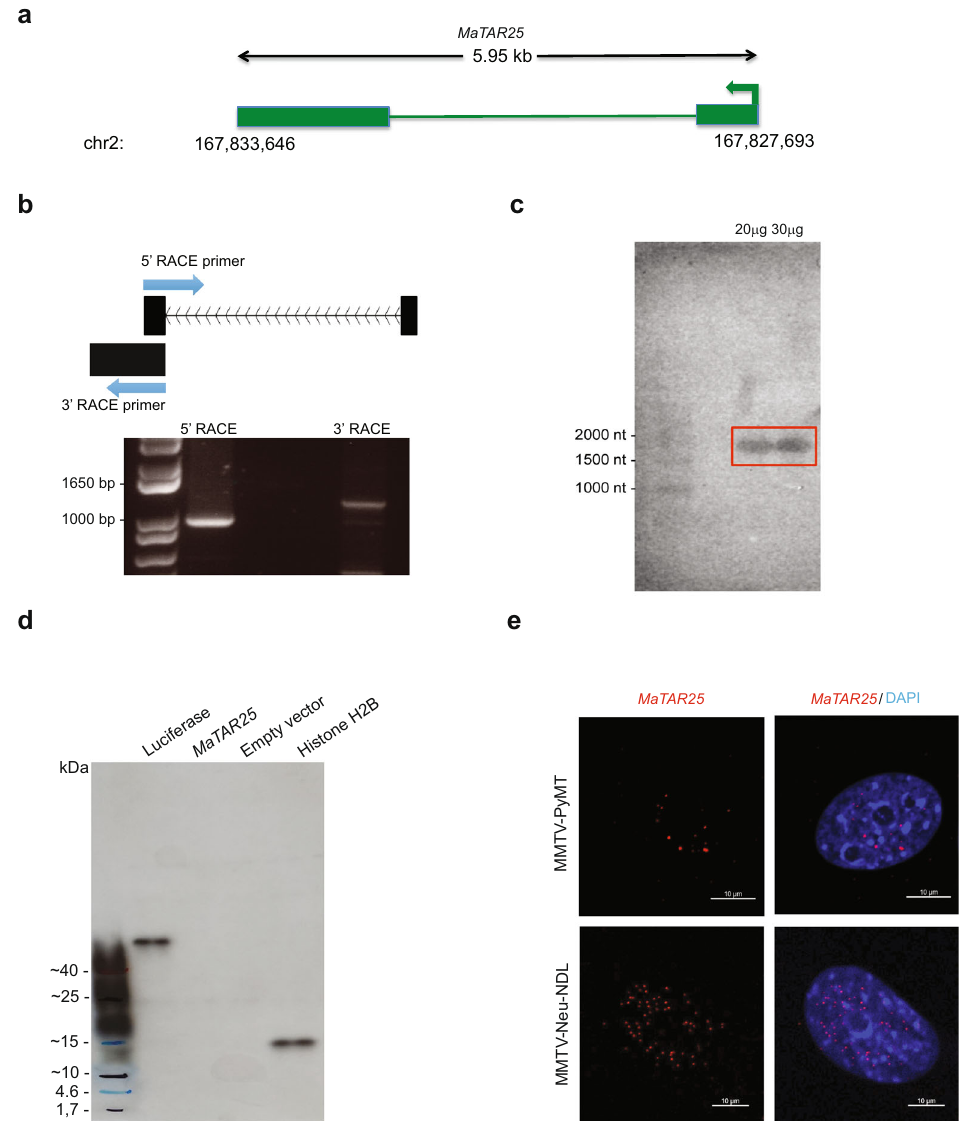
Fig. 1 Characterization of Mammary Tumor Associated RNA 25 ( MaTAR25 ). a Representation of the MaTAR25 gene locus. MaTAR25 is an intergenic lncRNA gene located on mouse chromosome 2, and the MaTAR25 RNA transcript contains 2 exons and a poly (A) tail. b 5 ′ and 3 ′ rapid ampli fi cation of cDNA ends (RACE) was performed to identify the full-length MaTAR25 transcript. Three independent experiments were performed, and a representative gel image is shown. c The full-length MaTAR25 transcript was con fi rmed by northern blot analysis to be ~2000nt. In total, 20 μ g or 30 μ g of total RNA samples extracted from MMTV-PyMT primary cells were electrophoresed on a 1% agarose gel and probed. Two independent experiments were performed, and a representative gel image is shown. d In vitro transcription and translation reactions were performed to con fi rm that MaTAR25 does not produce a peptide. The reaction products were loaded on a 4 – 20% gradient SDS-PAGE gel, and the signals were detected by HRP-conjugated streptavidin. Luciferase control DNA and Xenopus laevis Histone H2B (HISTH2B) expressing plasmids were used as positive controls and empty vector as a negative control. Three independent experiments were performed, and a representative gel image is shown. e Representative smRNA-FISH images showing localization of MaTAR25 RNA transcripts (red) within nuclei of MMTV-PyMT and MMTV-Neu-NDL primary cells. Scale bars are 10 μ